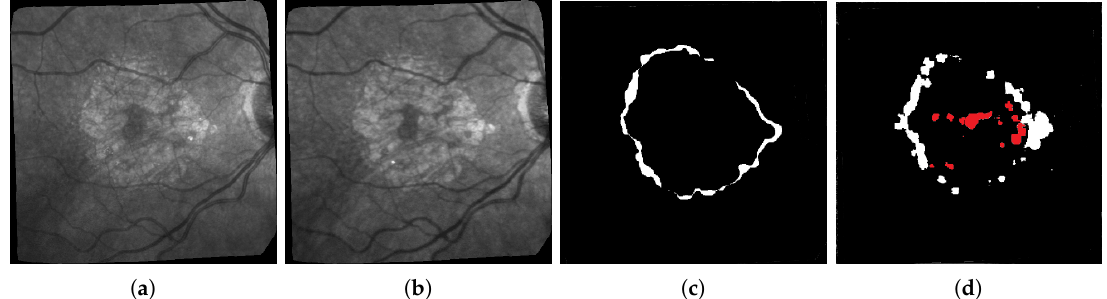
Figure 13. Example of a segmentation in (d) where all changes detected in red will be considered false positive since the ground truth does not consider changes within existing lesions regardless of if they are structural of textural. ( a ) Image of patient 018 at time t ; ( b ) Image of patient 018 at time t + 1; ( c ) Proposed Ground truth; ( d ) Proposed